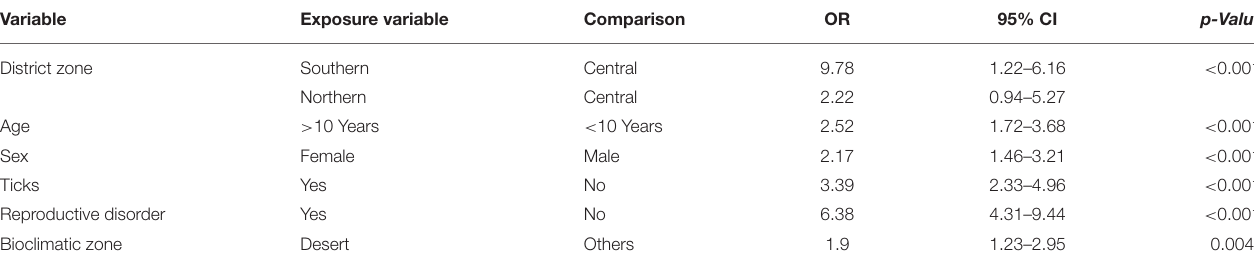
Bioclimatic zone